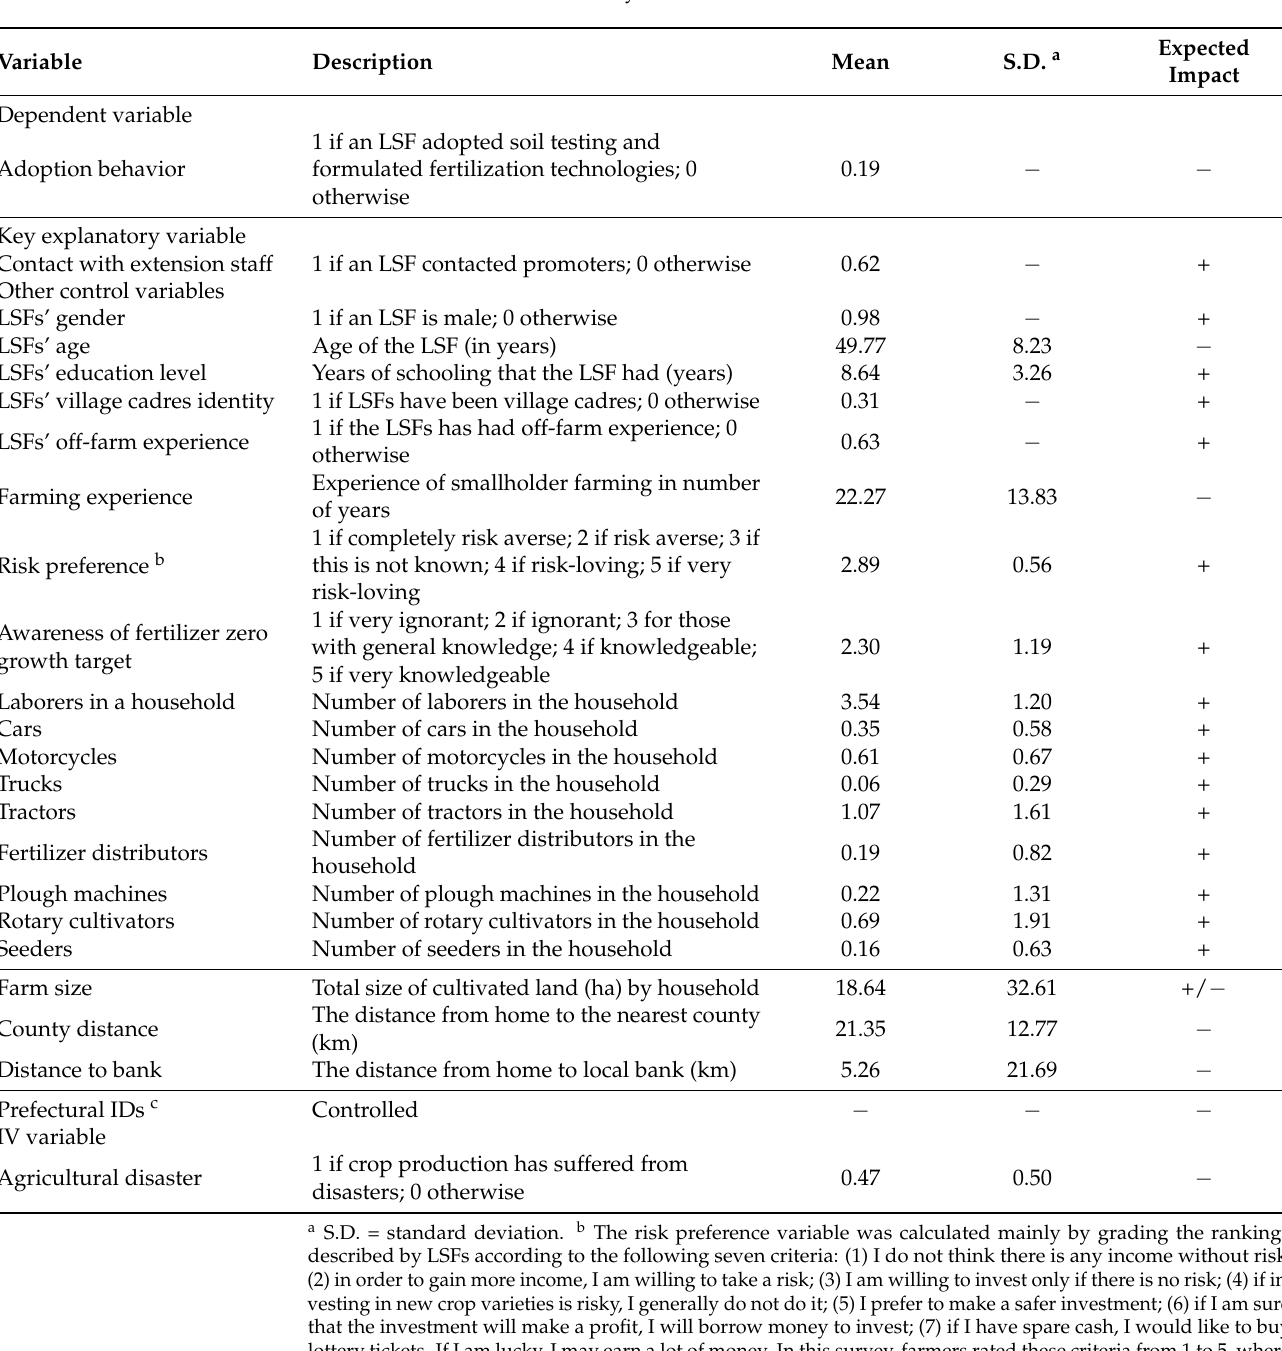
Table 1. Definition and summary statistics of the